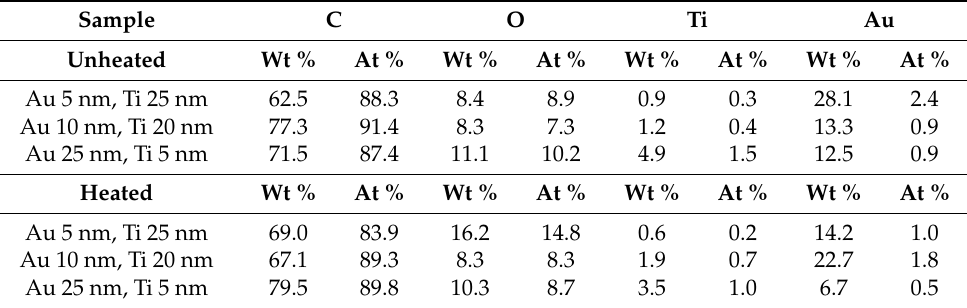
Table 4. The concentration of individual elements contained in unheated and heated samples with a lower layer of titanium and a top layer of gold obtained by EDS. Values for mass (Wt) and atomic (At) percentages.